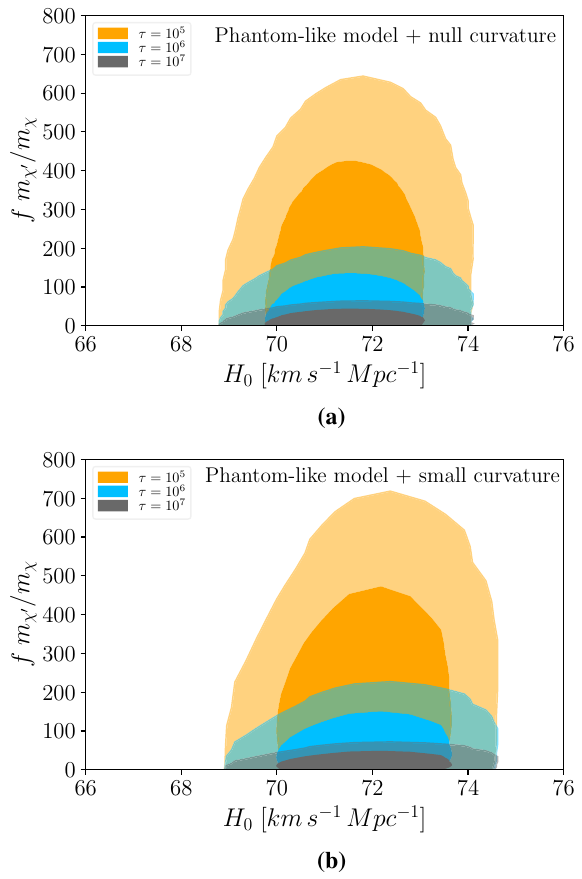
Figure 2. Connection between our model and the value of Hubble constant in phantom-like cases. ( a ) The contours correspond to cases where χ ′ lifetime is 10 CL, while the smaller is related to 68% of CL. It considers a universe with phantom-like quintessence and (cid:31) N eff in cosmology with null curvature. The bounds were built using Planck 2018 CMB data, BAO, and type Ia data from the Pantheon sample. ( b ) This case also considers a universe with phantom-like quintessence and (cid:31) N eff , but in this case, a small curvature is